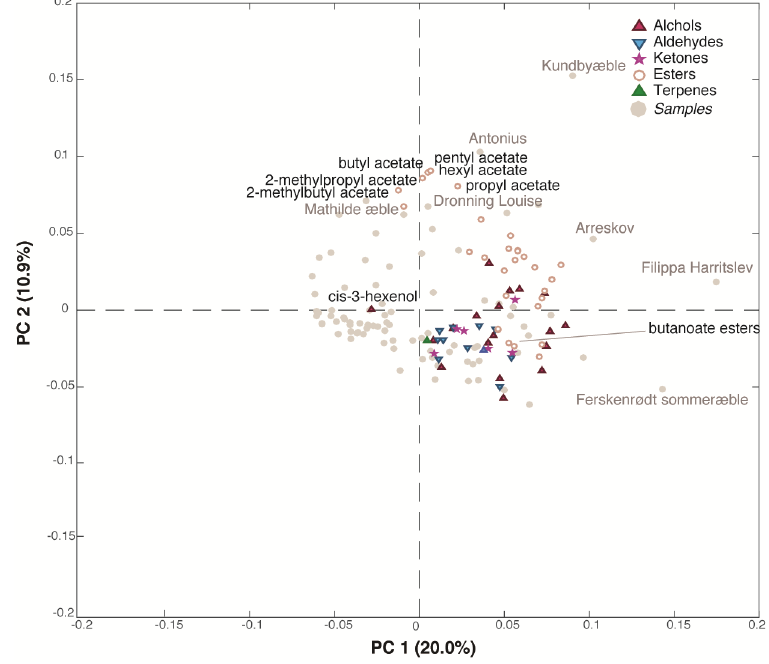
Figure 3. Bi-plot of the PCA model performed on the dynamic headspace GC-MS